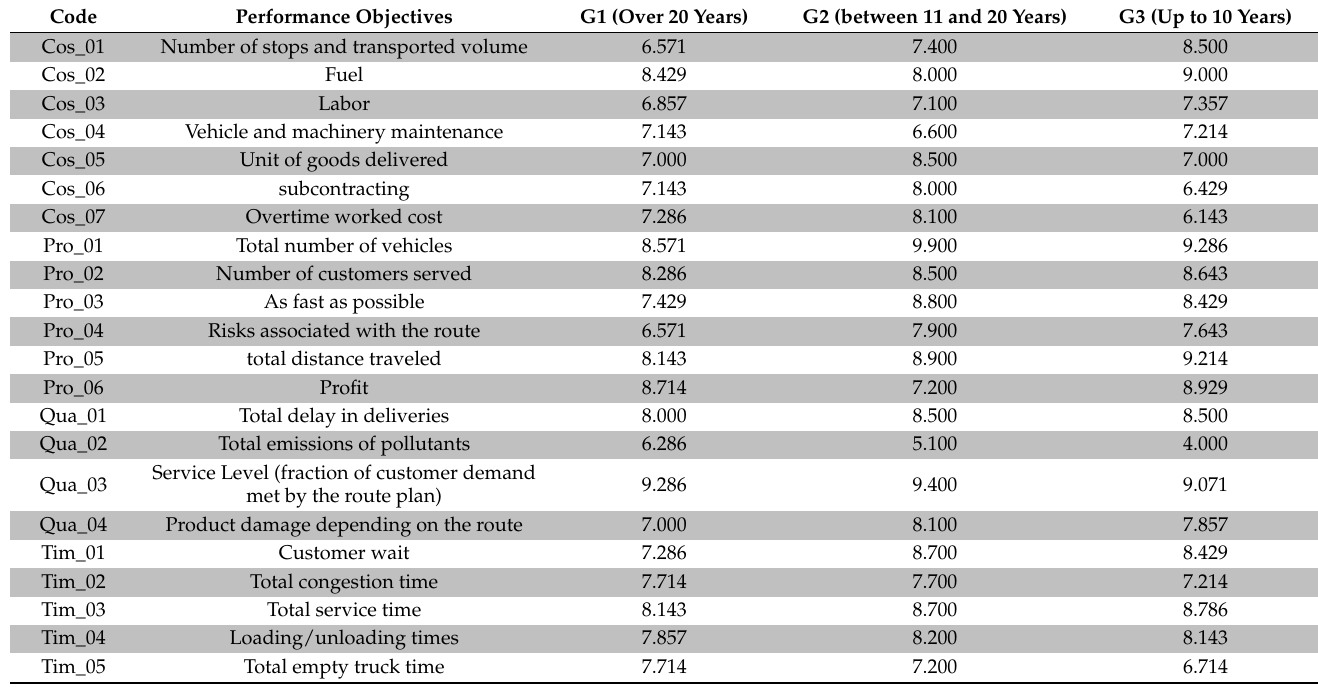
Table 2. Averages are assigned to performance objectives. Source: authors.